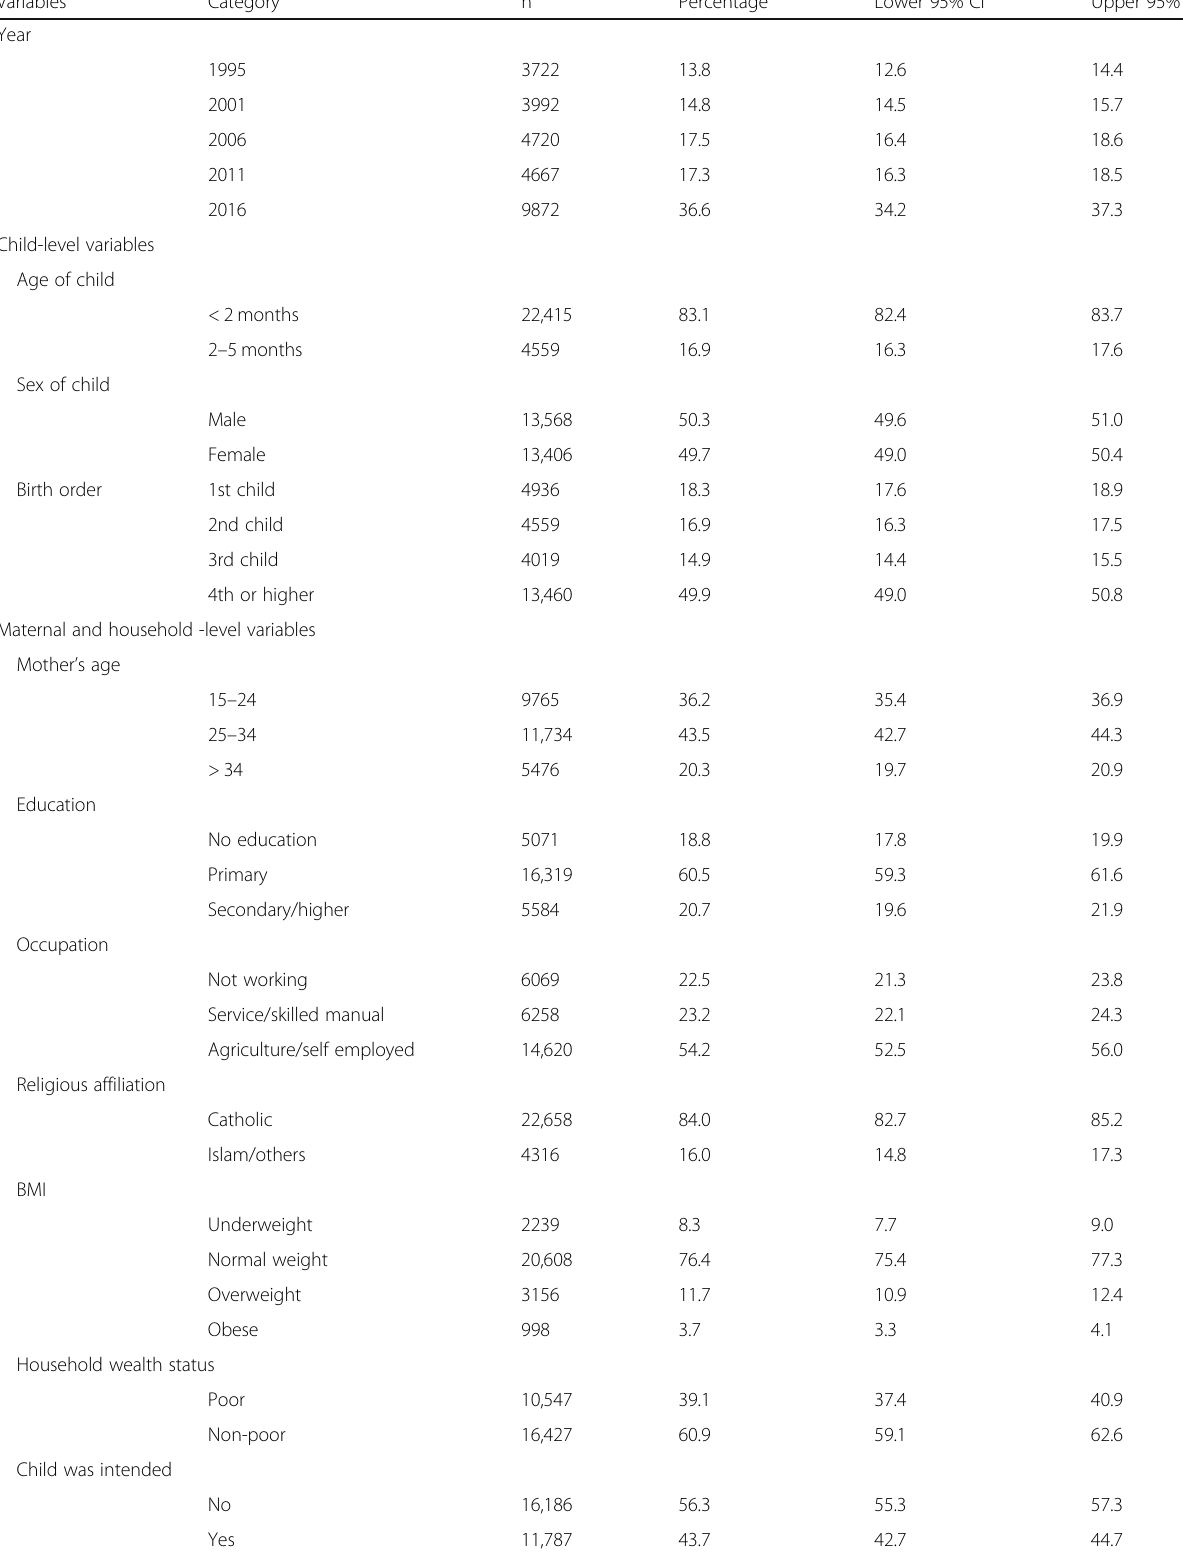
Table 2 Sample characteristics ( n =